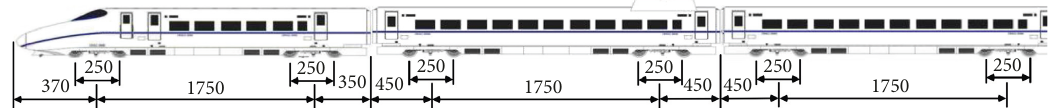
Figure 2: Composition and main dimensions of the considered CRH2C train (unit: cm). Table 1: Degrees of freedom of the vehicle.